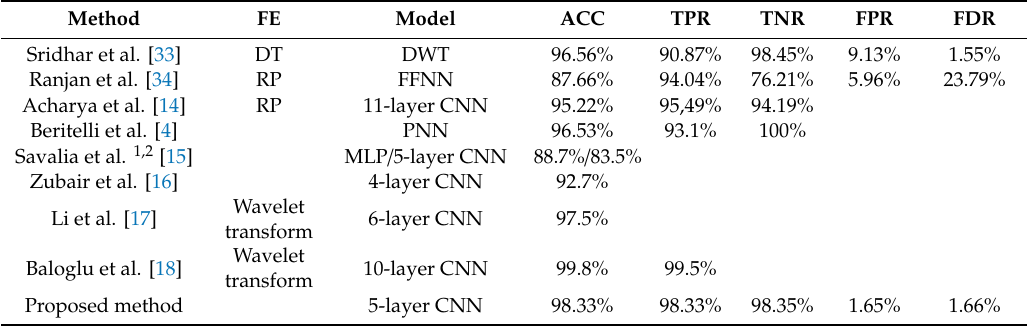
Table 4. Comparison between the proposed method and those previously